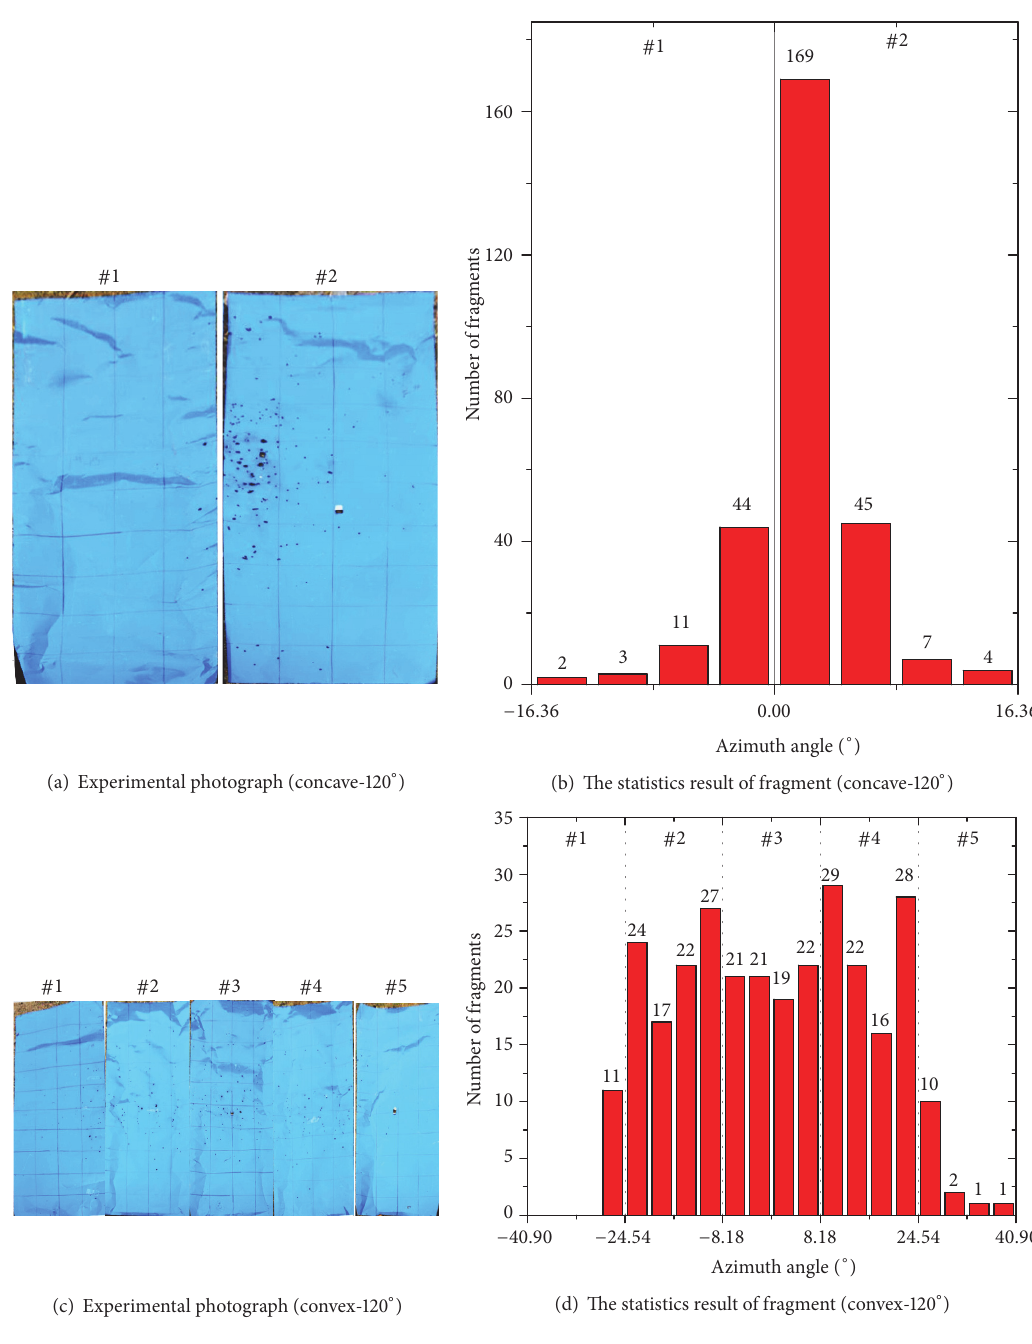
Figure 4: The experimental photograph and statistics of the asymmetric structures.